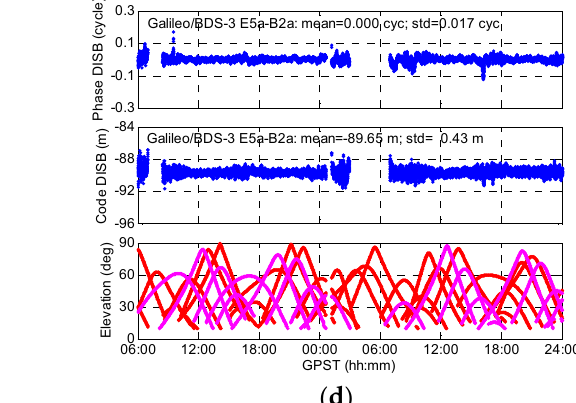
E5a-B2a ( d ) for short baseline based on different receiver types (iGMAS and M300Pro receivers).